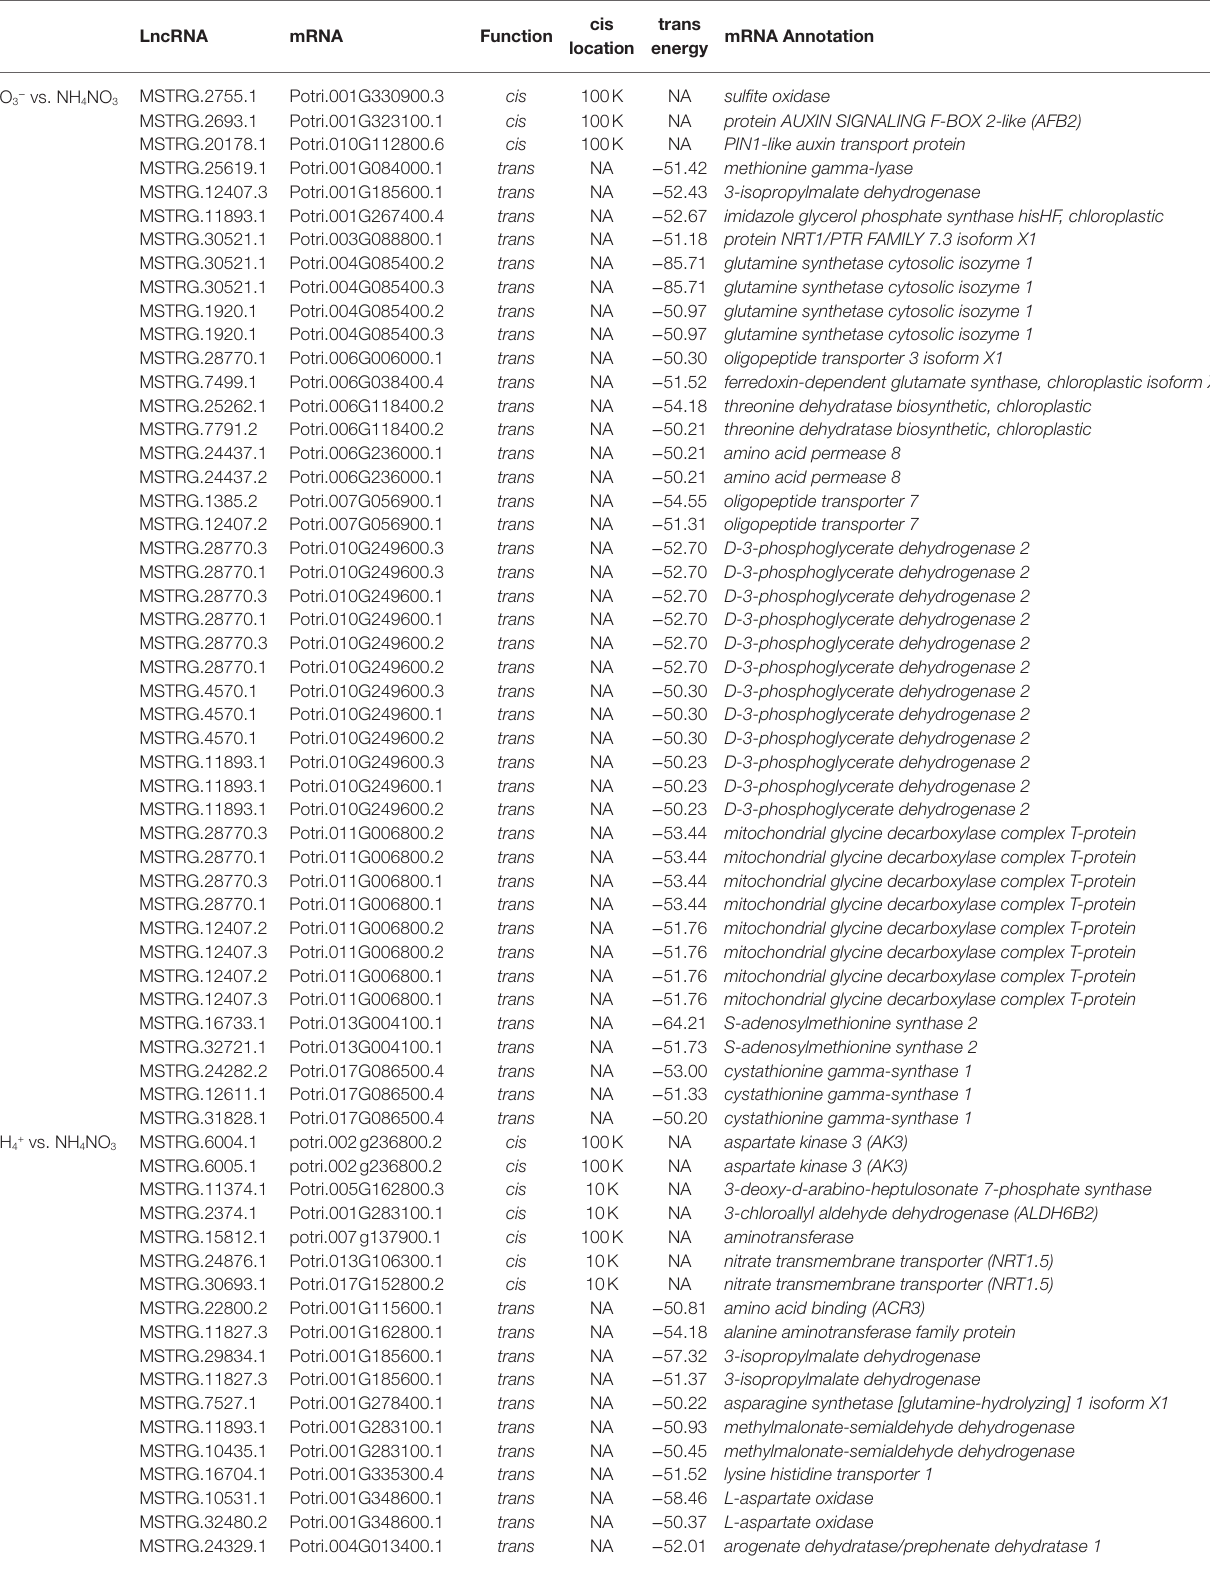
cis trans mRNA Annotation location energy